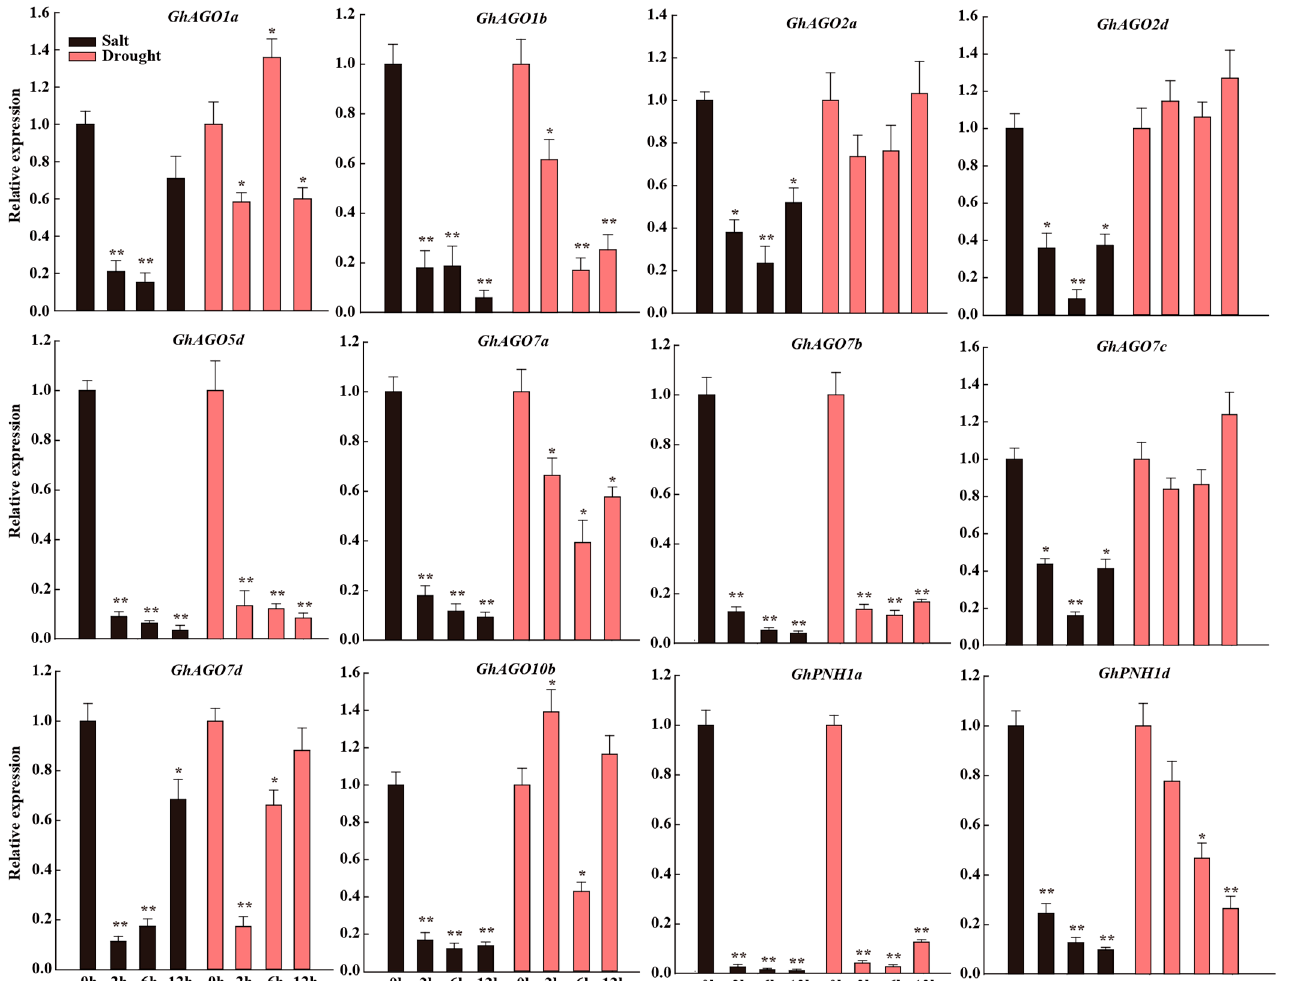
Figure 8. Expression analyses of the GhAGO genes in roots under salt and drought stresses. qPCR was used to determine the expression profiles of 12 GhAGO genes under salt and drought stresses. The standard deviation is indicated by the error bars, and “*” (Tukey’s HSD, p ≤ 0.05) and “**” ( p ≤ 0.01) indicate significant differences between the treatment and control.